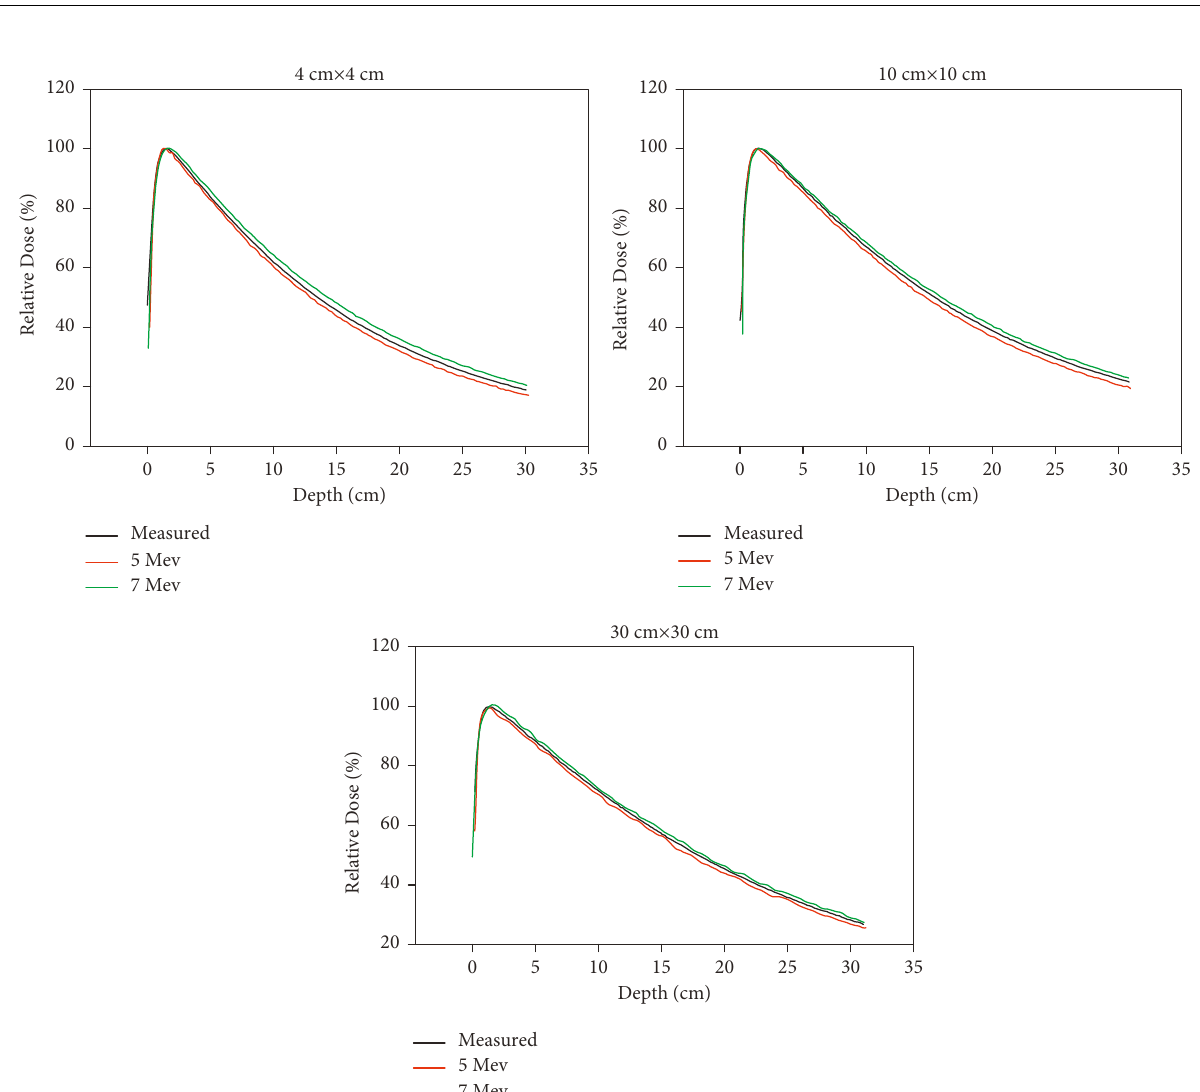
Figure 3: The influence of mean energy of incident electron on PDDs for 4 × 4, 10 × 10, 30 × 30cm 2 fields. Red curve represents the dose curve when the energy is 5MeV, the green curve represents the dose curve when the energy is 7MeV, and the black curve represents the measured dose